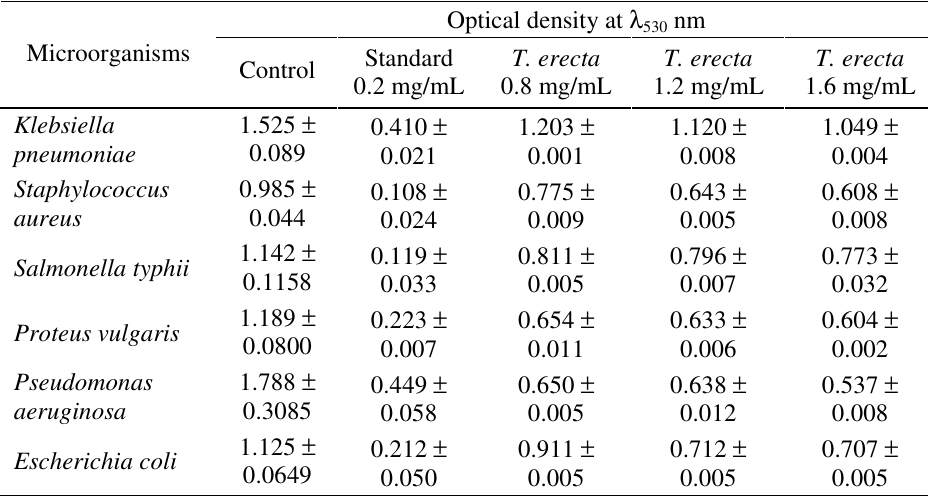
Table 3. Evaluation of the antimicrobial bioassay of ethanolic extract of Tagetes erecta L